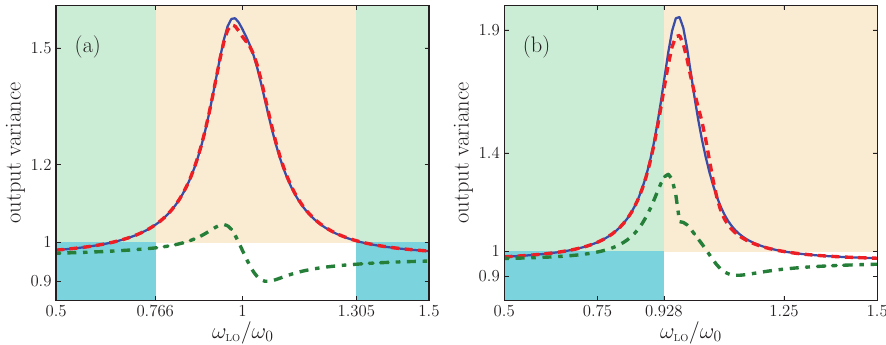
Figure 8. Same as Figure 7 but now for incident and detection angles of θ = 60 ◦ .